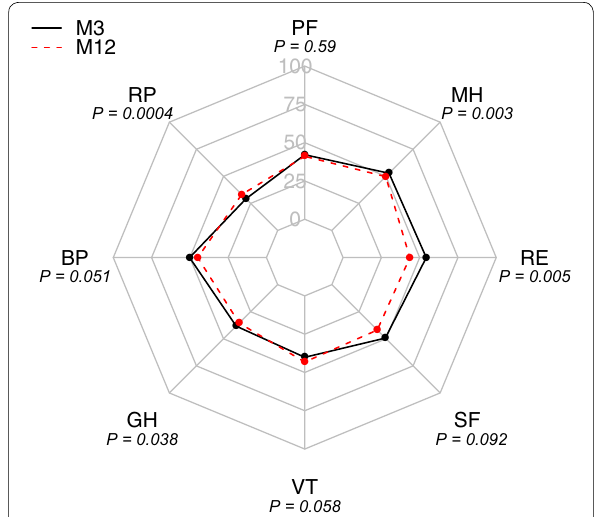
Fig. 2 Radar chart of the health‑related quality of life (HRQOL) at 3 and 12 months after ICU discharge. M3, 3 months after ICU discharge; M12, 12 months after ICU discharge; RP, role—function physical; PF, physical functioning; MH, mental health; RE, role—emotional; SF, social functioning; VT, vitality; GH, general health; and BP, bodily pain